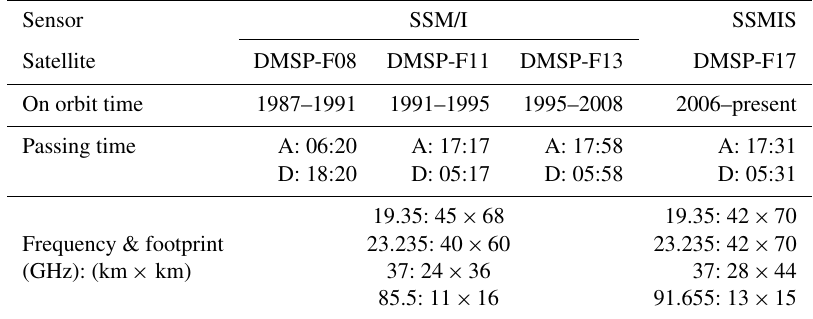
Table 1. Summary of the main passive microwave remote sensing